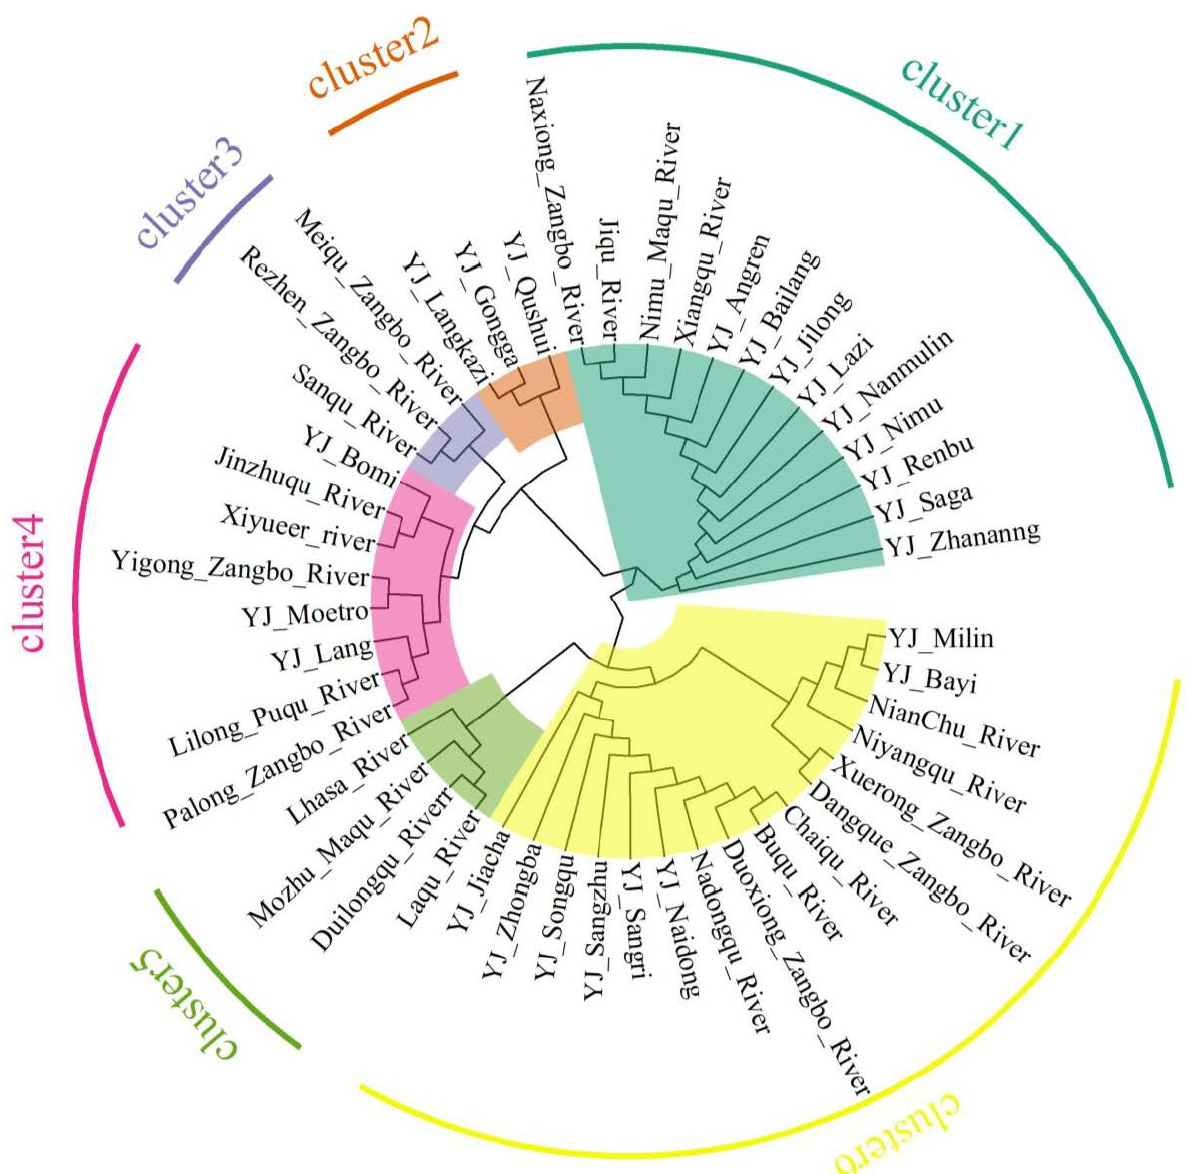
Figure 6. Ward clustering for non-native fish in the Yarlung Zangbo River Basin showing 6 main groups (clusters 1–6) .